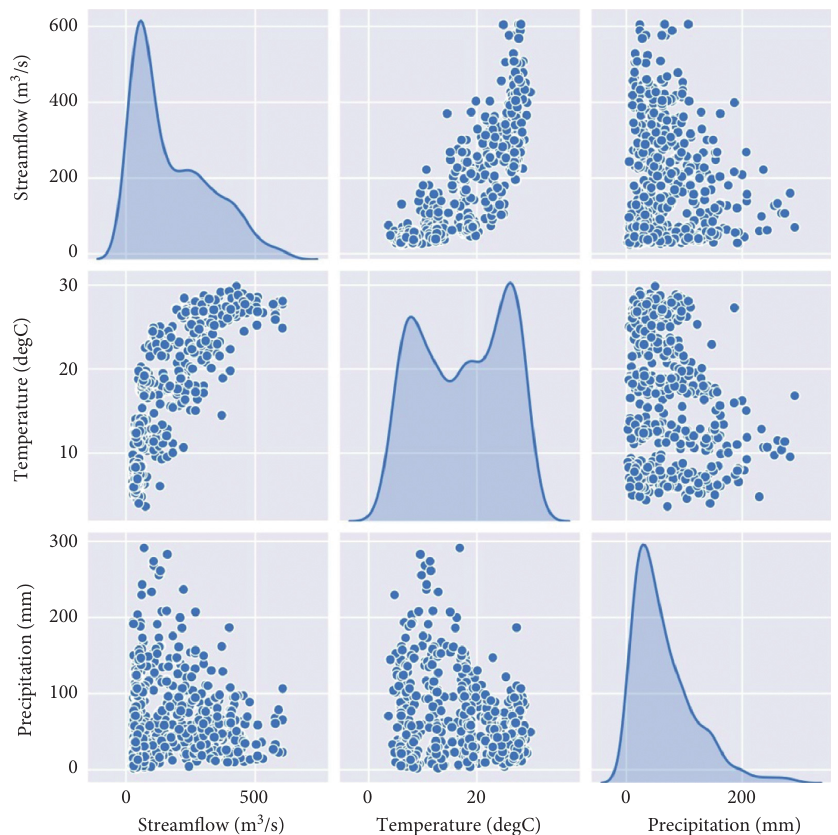
Figure 2: Pairplot demonstrating pairwise relation between streamflow, temperature, and